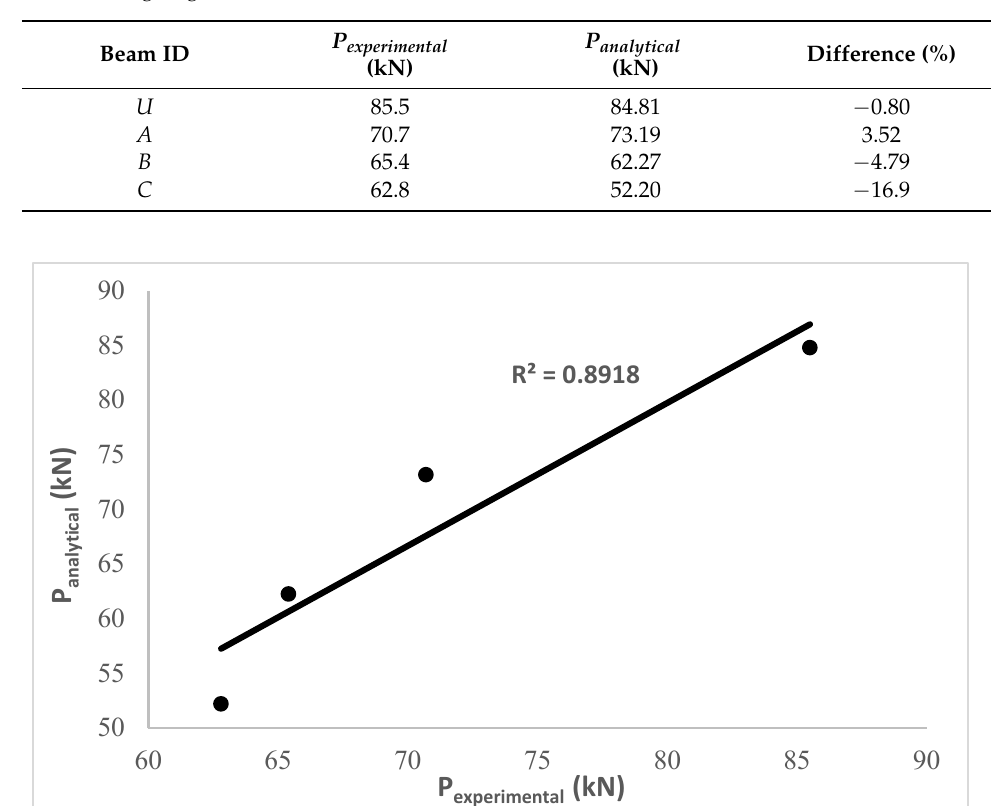
Figure 17. Comparison between experimental and analytical results using actual mass loss. Table 4. Experimental and analytical values of load ‐ carrying capacities of control and corroded RC beams (using targeted mass loss).